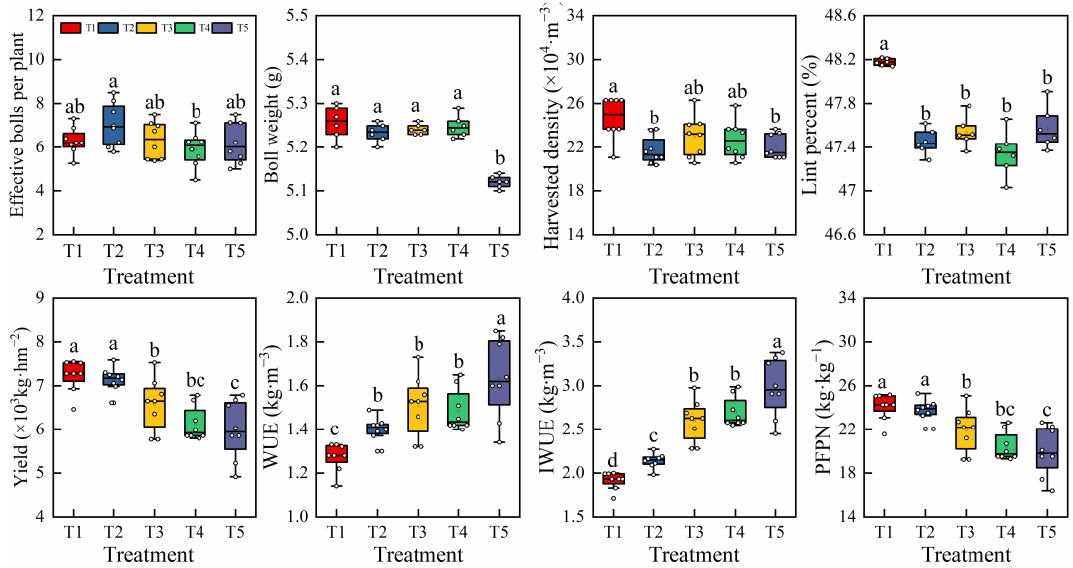
Figure 5. The yield components and WUE, IWUE and PFPN for treatments. Different letters above the boxes indicate a significant difference at P < 0.05 according to the Duncan